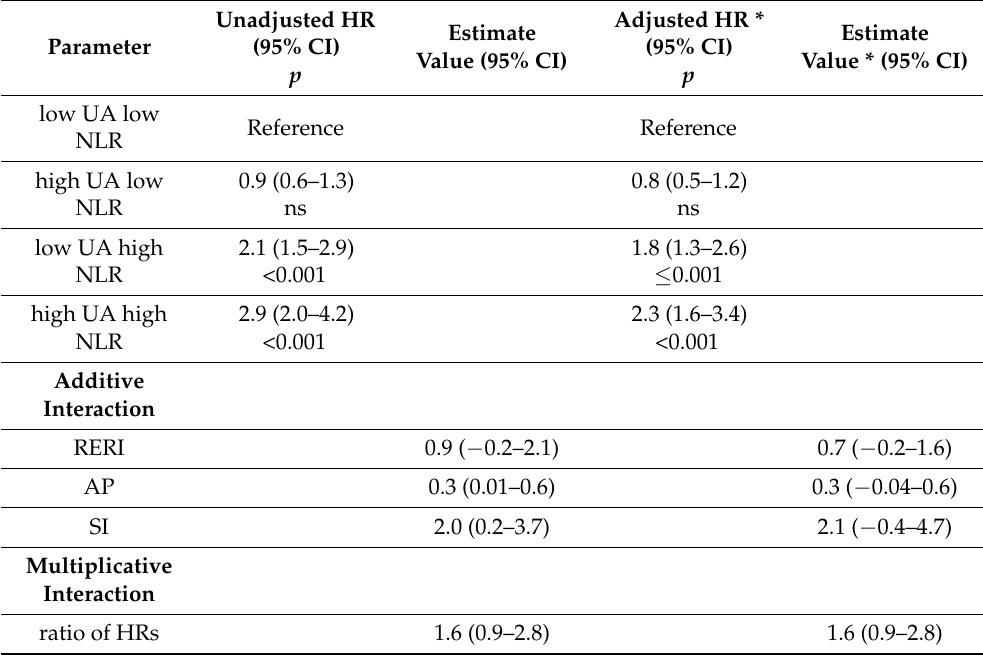
Table 6. Interactive effect of UA and NLR on hard